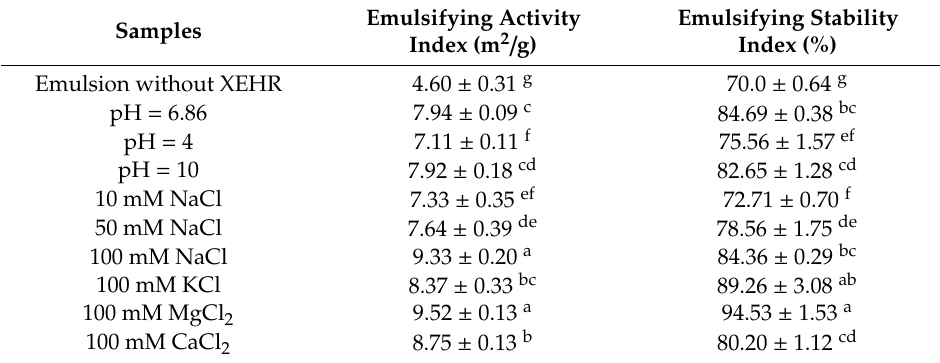
Table 4. Emulsifying activity index (EAI) and emulsifying stability index (ESI) values for emulsions made with the XEHR with di ff erent pH, salt concentrations, and salt